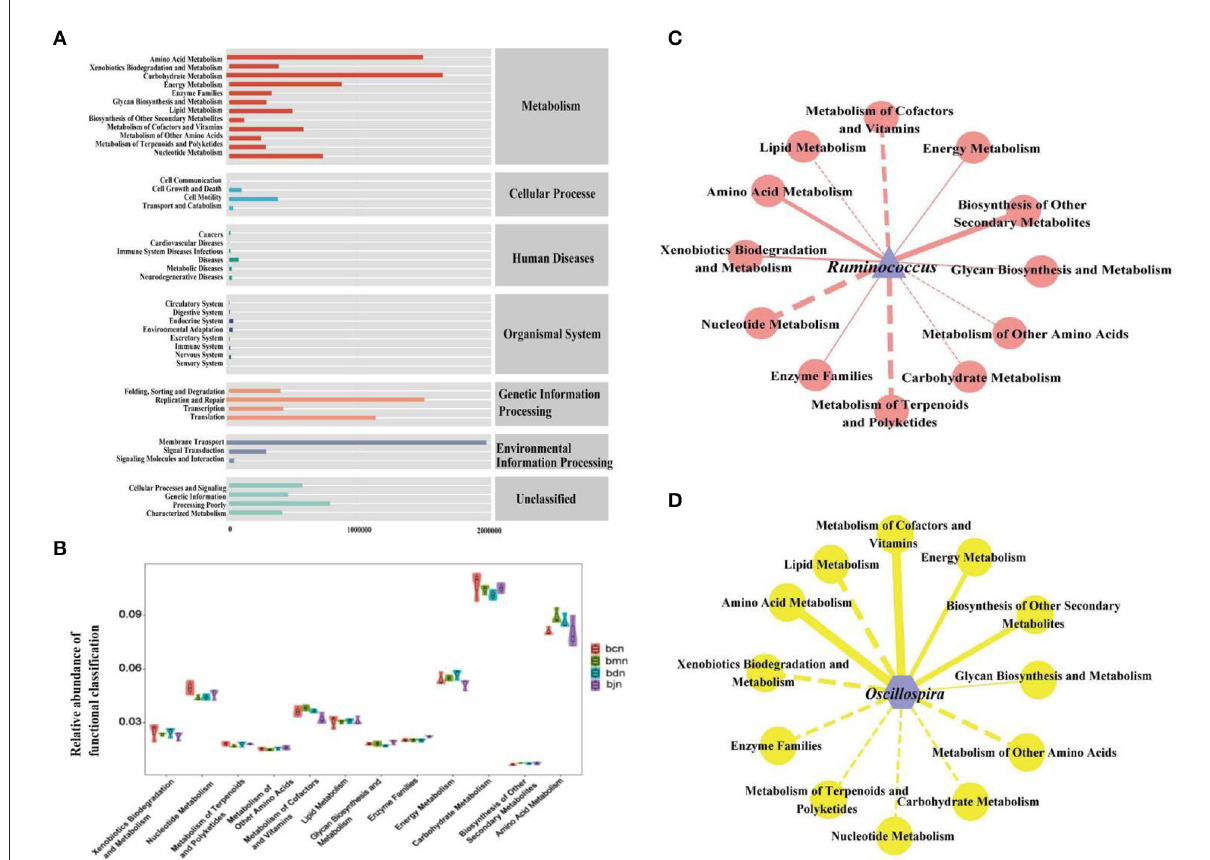
FIGURE6 Functional analysis of intestinal contents microbiota. (A) Predicted abundance of KEGG function. (B) Histogram of metabolic function. (C) Interaction network of “ Ruminococcus -metabolic function”. (D) Interaction network of “Oscillospira-metabolic function.” Solid line represented positive correlation, dotted line represented negative correlation. The thickness of the line indicated the strength of the correlation. bcn: normal saline-treated basal diet group; bmn: normal saline-treated high-fat diet group; bdn: DO traditional decoction-treated high-fat diet group; bjn: lipid-lowering decoction-treated high-fat diet